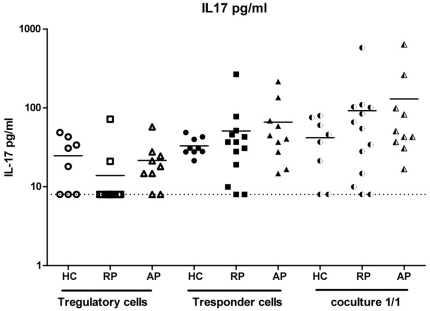
Concentration of IL-17 in co-culture supernatants.IL-17 was quantified in supernatant using a multiplex fluorescent bead immunoassay: the levels of IL-17 produced by Treg, responder T cells and co-culture were not statistically different between the 3 groups.